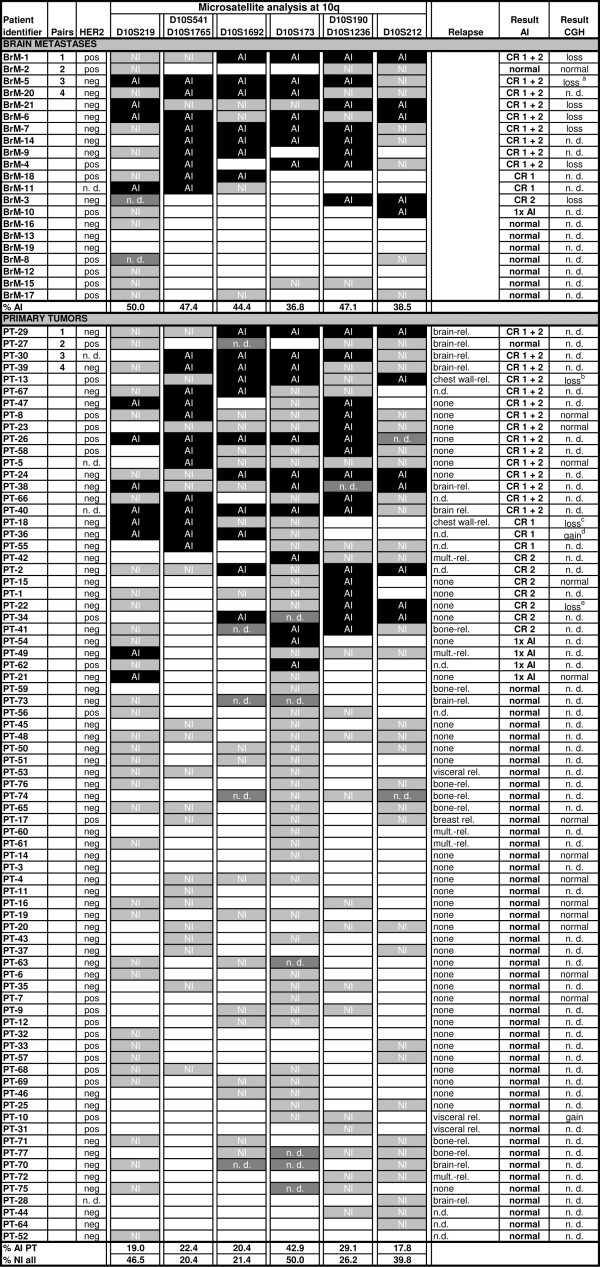
Microsatellite analyses for AI on 10q in primary breast cancers and metastases. Base-pair position and the markers used are indicated on the top line. The result for each marker is shown as follows: AI, black; noninformative, light gray; unavailable measurement, dark gray; and informative without changes, white box. 1, 2, 3, 4, matching primary tumors and brain metastases; a: loss from bp:100000000; b: loss from bp: 95000000; c: loss from bp:114000000; d: gain until bp:100000000; e: loss from 80-90000000; n.d., not determined; NI, noninformative marker; CR 1, core region 1; allelic imbalance around makers D10S173 and D10S190; CR 2, core region 2; allelic imbalance around markers D10S541 and D10S1765.